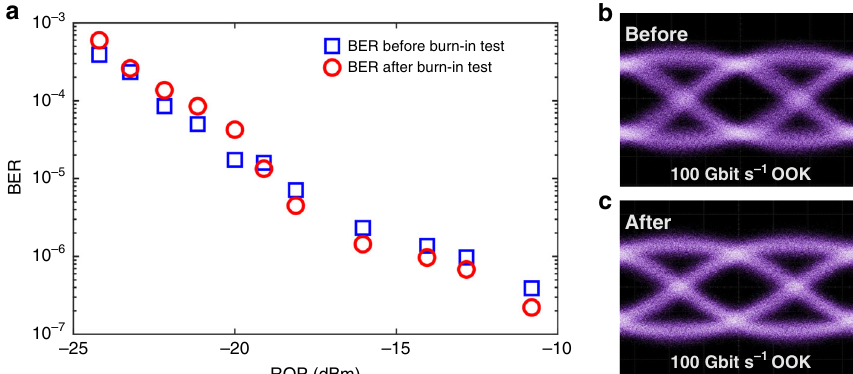
Fig. 5 100 Gbit s − 1 operating after long-term high-temperature storage. a Measured curves of BER versus the received optical power (ROP) of 100Gbits −